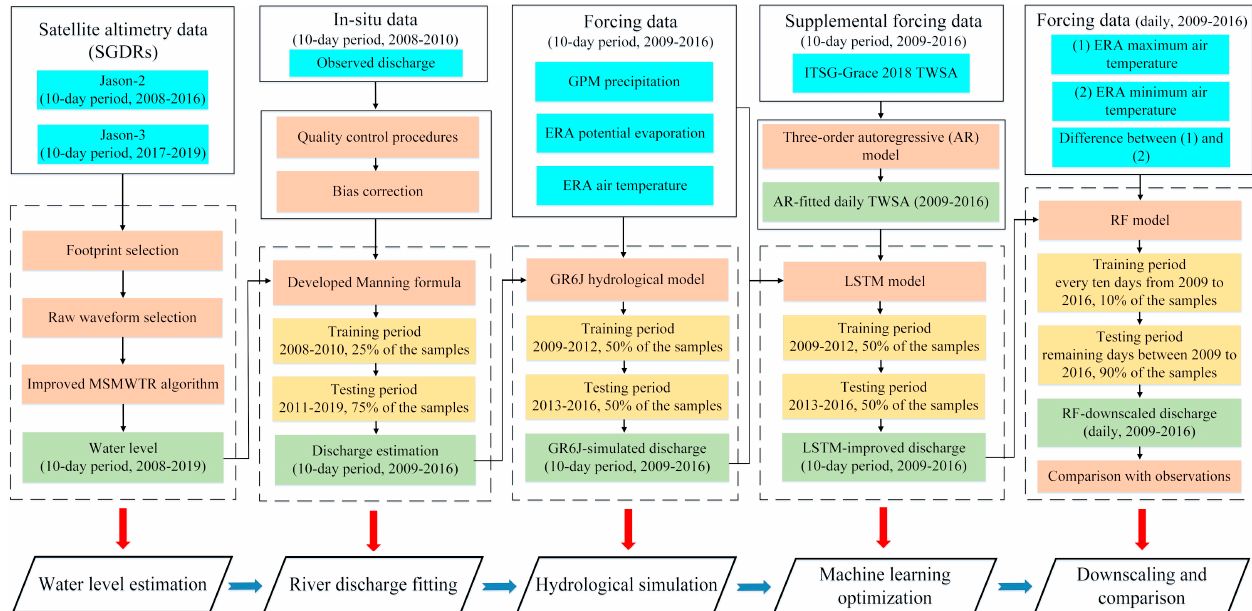
Figure 3. Work chain considered in this study.